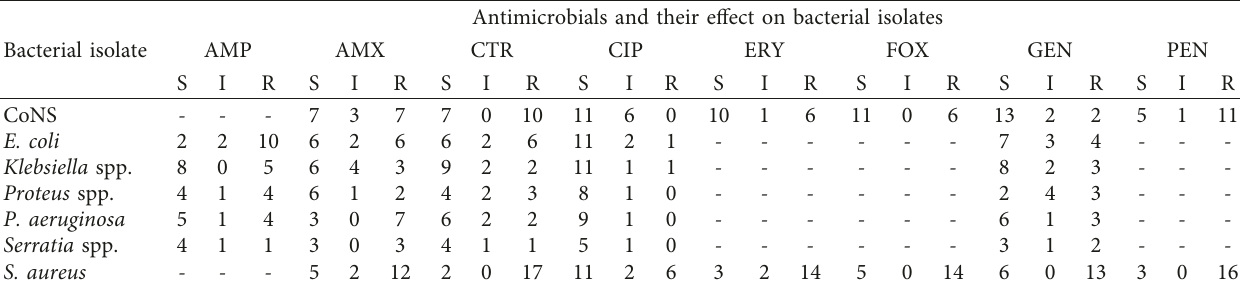
Table 4: Multidrug resistance profile of nosocomial bacteria at Mizan-Tepi University Teaching Hospital, 2017. Bacterial isolate Number of MDR organism Antimicrobials resisted by most isolates CoNS 8/17 (47%) AMX, ERY, PEN E. coli 4/14 (28.6%) Klebsiella Proteus Serratia MDR � multidrug